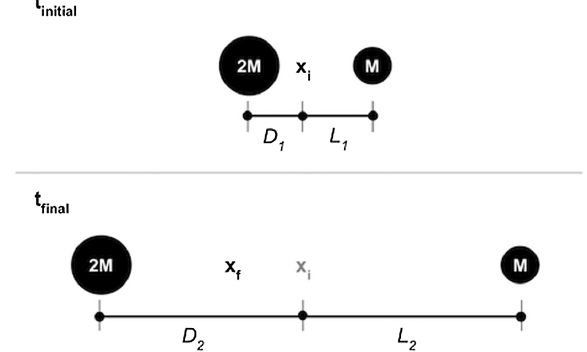
FIG. 2. The diagram Adolfo originally drew. We have modified it slightly for clarity and ease of